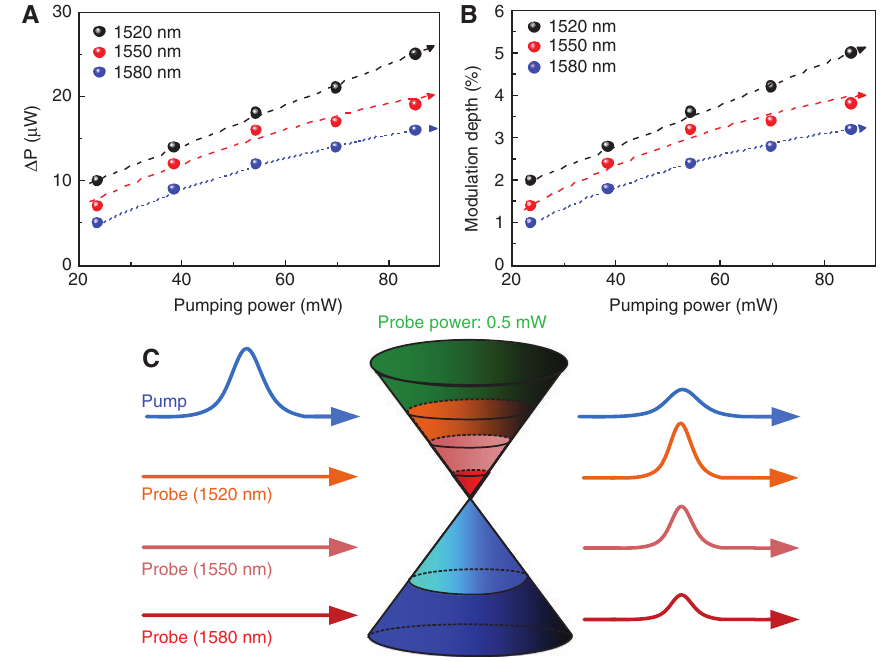
Figure 4: (A) Switching response and (B) modulation depth of few-layer graphene all-optical switcher with different probe wavelengths (probe power of 0.5 mW) and (C) schematic diagram of pump-probe analysis for performing the all-optical switching in few-layer graphene with intensive pump beam and weak probe beam at different